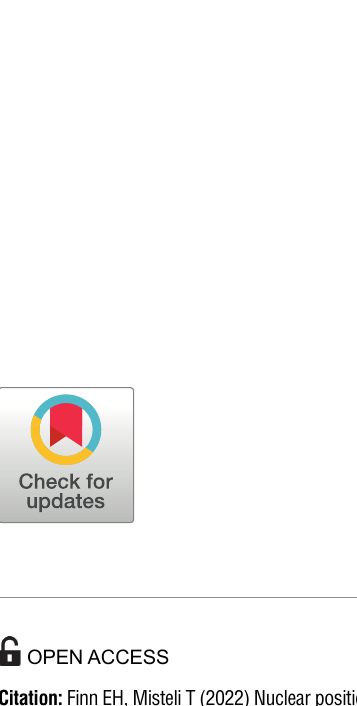
figshare.20205875 The python pipeline usedfor imageanalysis can be found at: